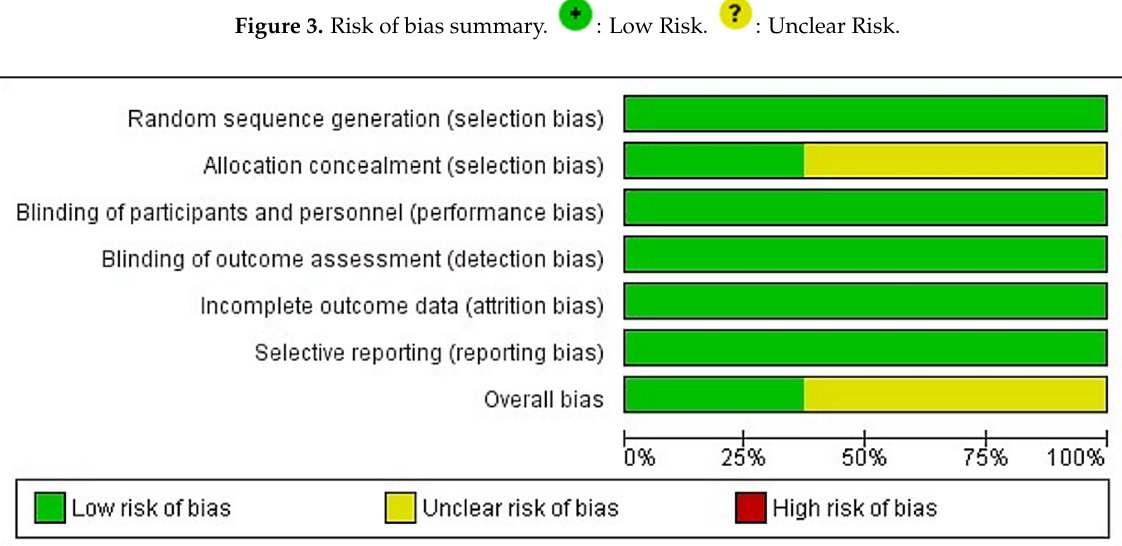
Figure 3. Risk of bias summary. : Low Risk. : Unclear Risk.